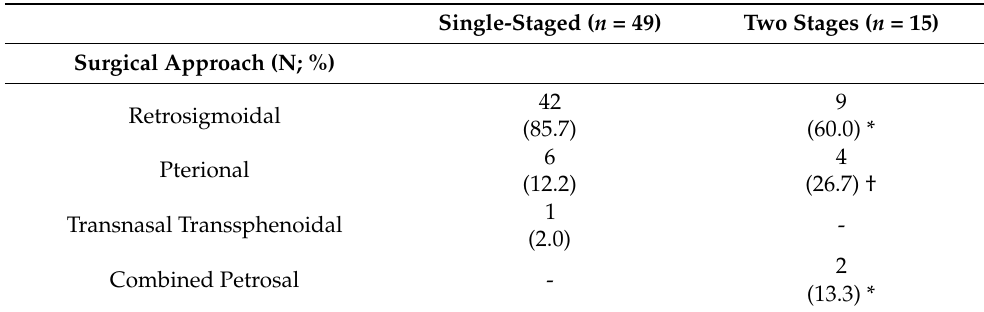
Table 4. Surgical approaches for single ( n = 49) and staged ( n = 15) resections. * 2nd pterional † 2nd